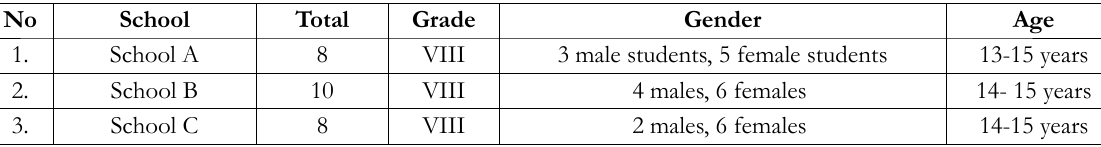
Table 2. Student